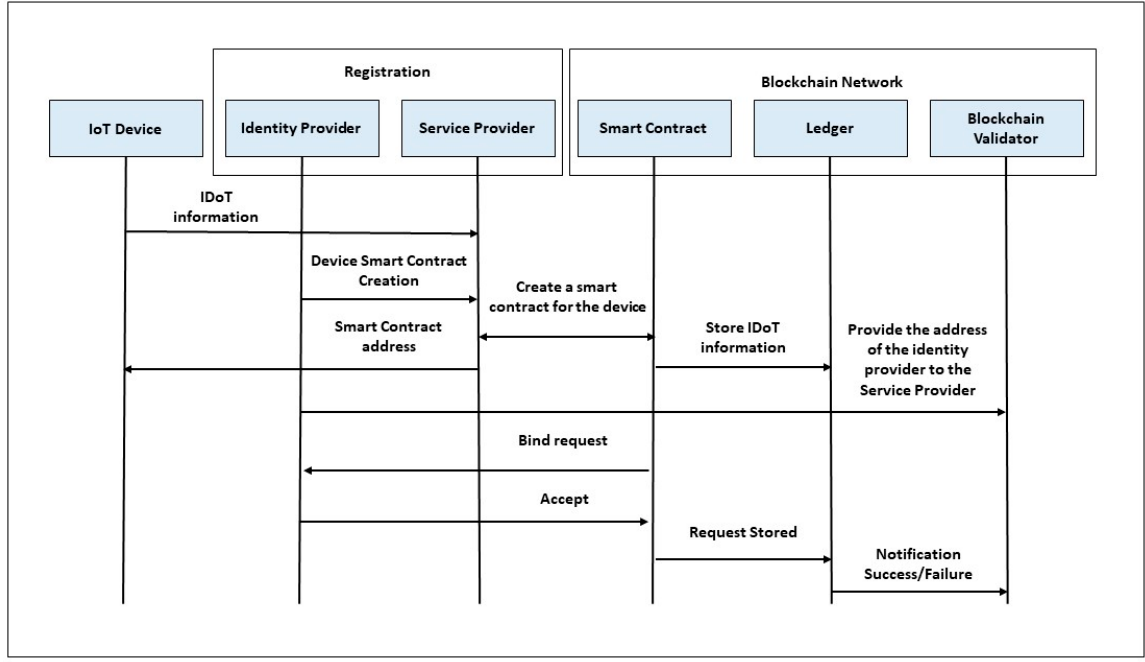
Figure 1. Proposed device registration process.